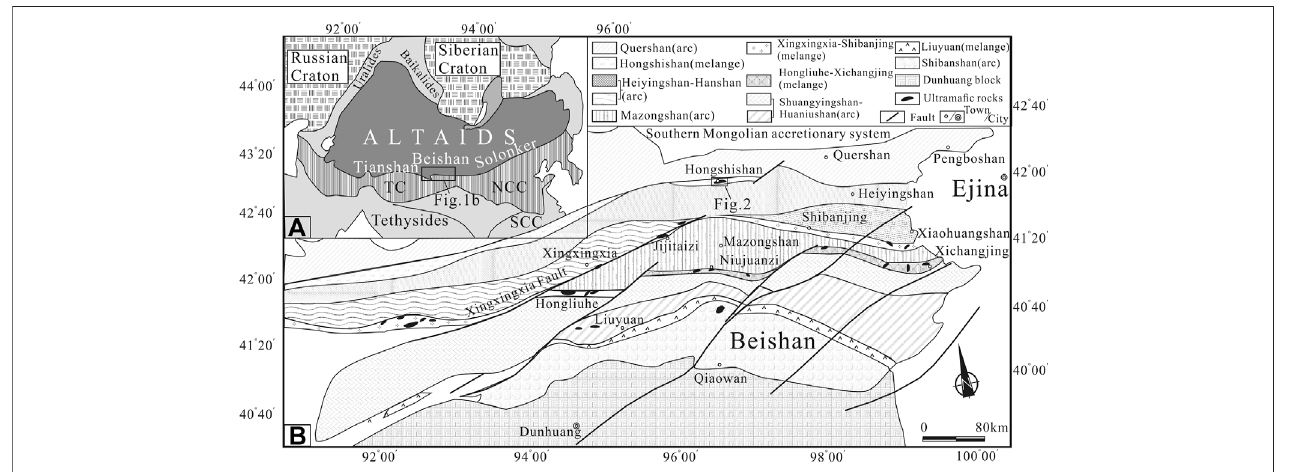
FIGURE 1 | (A) Simpli fi ed tectonic sketch map of Asia showing the location of the Beishan orogenic collage. (B) Simpli fi ed tectonic map of the Beishan orogen showing the tectonic subdivisions and study area (modi fi ed after Xiao et al., 2010; Song et al., 2015). TC, Tarim Craton; NCC, North China Craton; SCC, South China